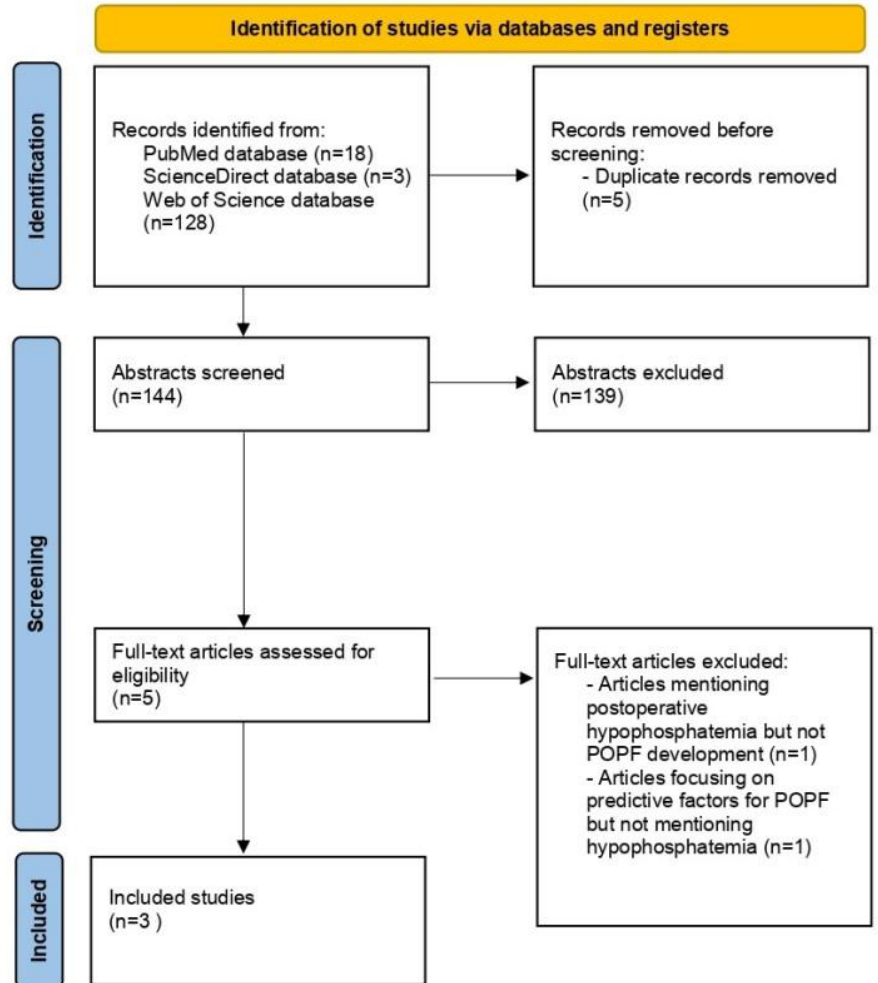
Figure 1. PRISMA flow diagram. One hundred forty-nine articles were identified through database searching. After removal of duplicates, title and abstract screening and further full-text assessment 3 retrospective studies were included in the analysis.